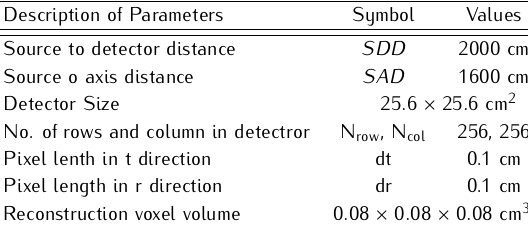
Table 2. Geometric parameters of cone-beam system.